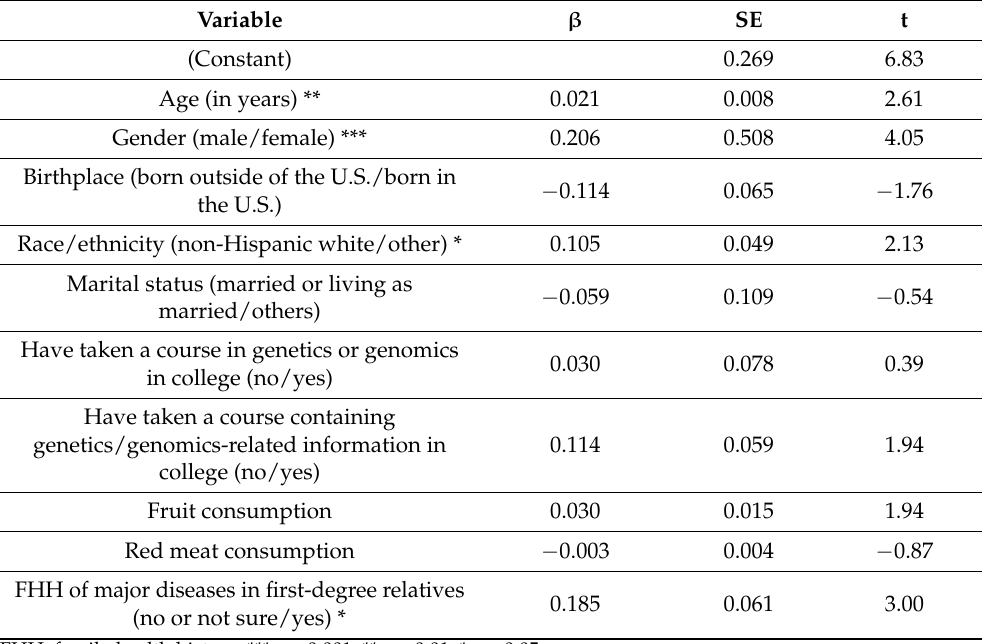
Table 2. Multiple linear regression analysis for college students’ interests in receiving FHH education.